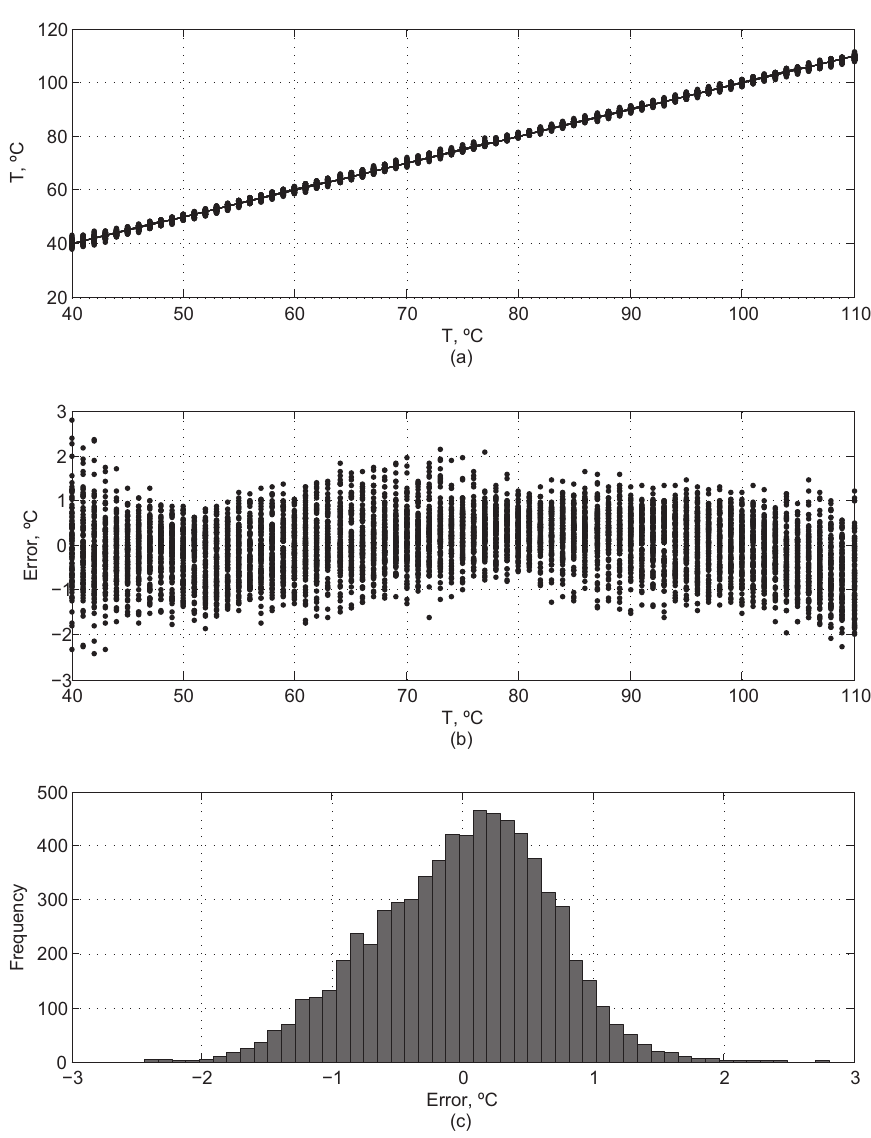
Figure 9. Sensor characterization under the effects of process